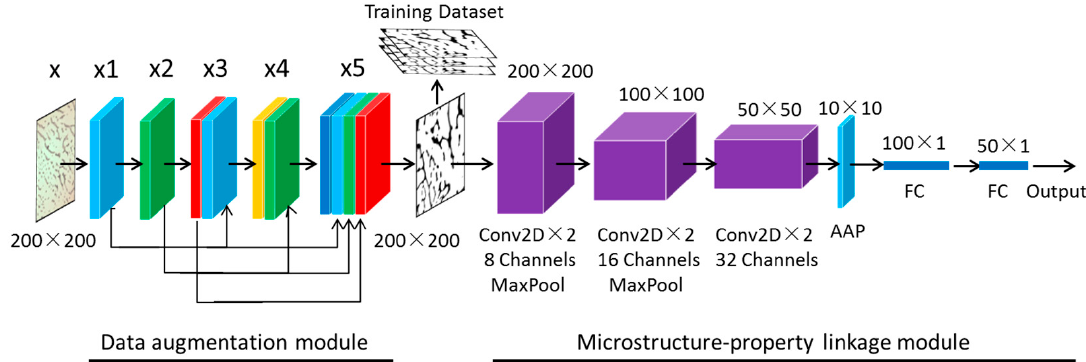
Figure 1. Architecture of the data augmentation and microstructure–property linkage model using deep learning.